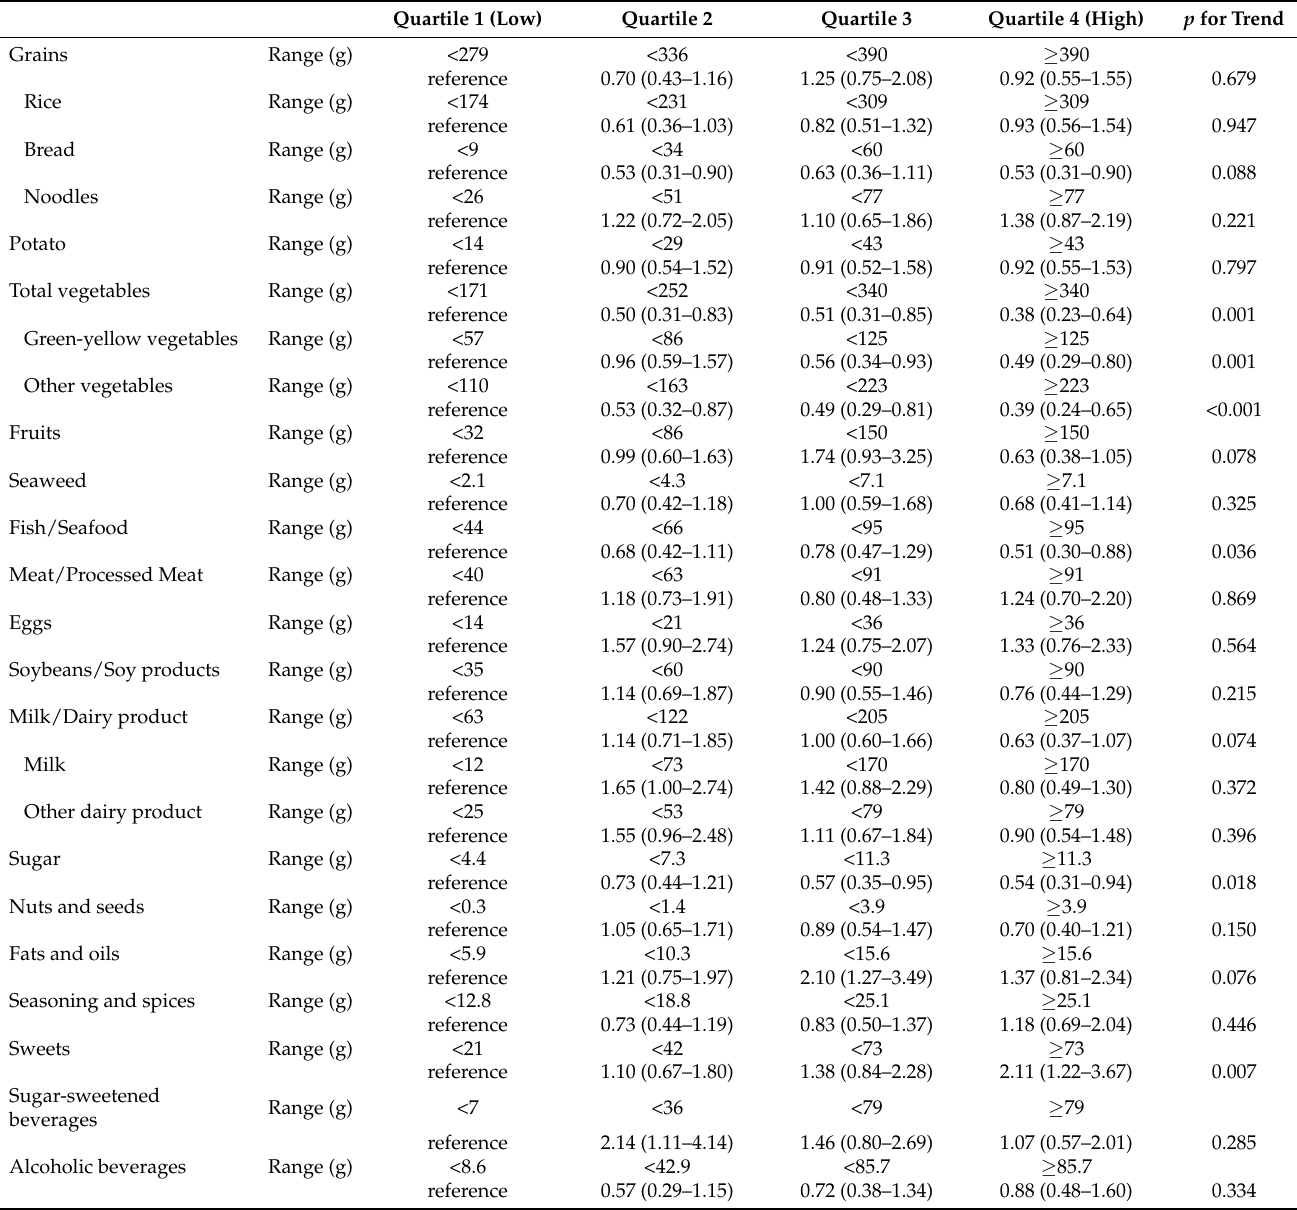
Table 4. Association between obesity and food groups according to quartiles with ranges by multi- variate quartile analysis